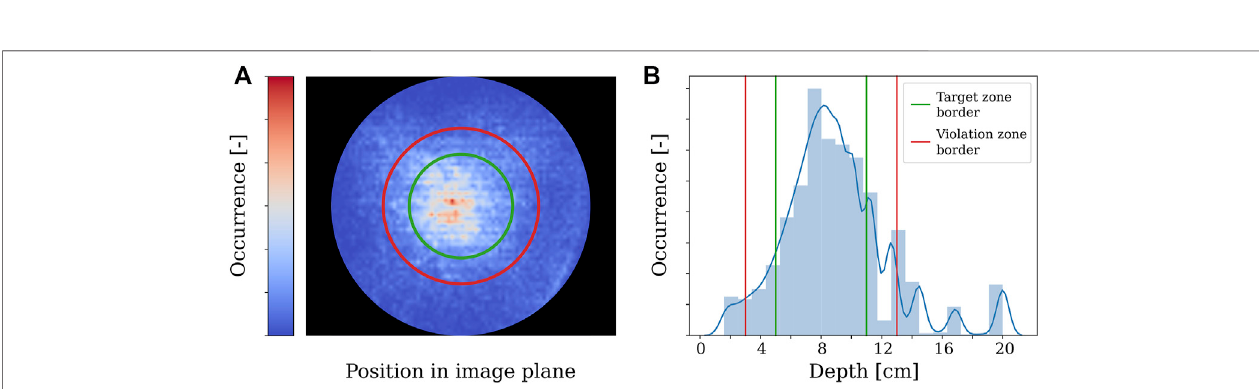
Frontiers in Robotics and AI |